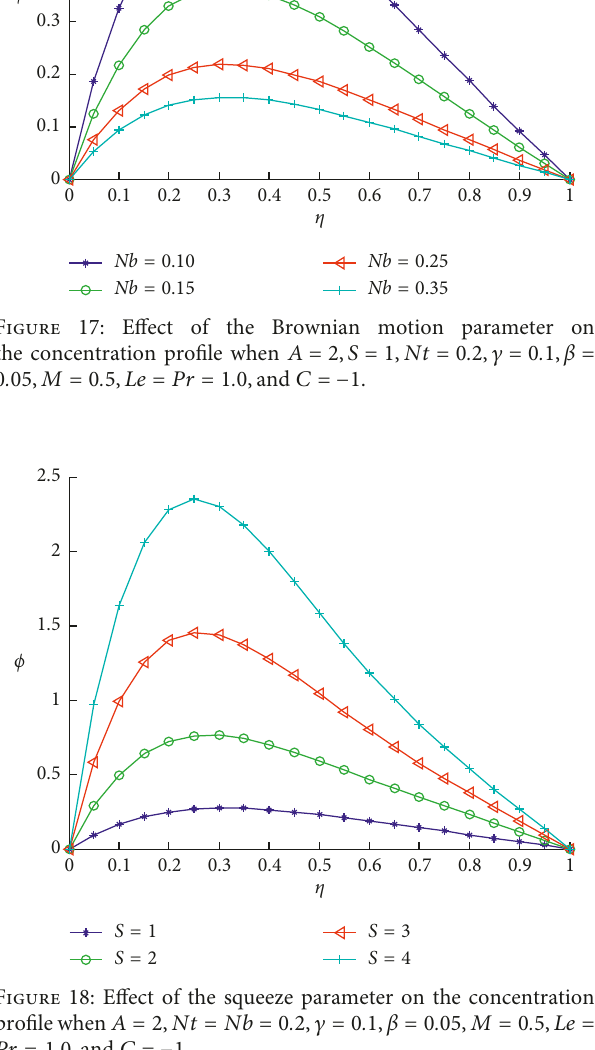
2 ,S 1 , c 0 . 1 ,Nb (cid:31) (cid:31) (cid:31) (cid:31)